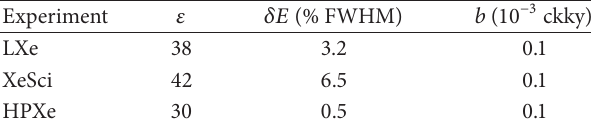
Table 2: Expected experimental parameters of the three xenon- based double beta decay technologies in a possible ton-scale experi- ment: (a) signal detection efficiency, which depends on the fraction of signal that escapes detection, 𝜀 ; (b) energy resolution, 𝛿𝐸 , at the 𝑄 value of 136 Xe; and (c) background rate, 𝑏 , in the region of interest around 𝑄 𝛽𝛽 expressed in counts/(keV ⋅ kg ⋅ y).